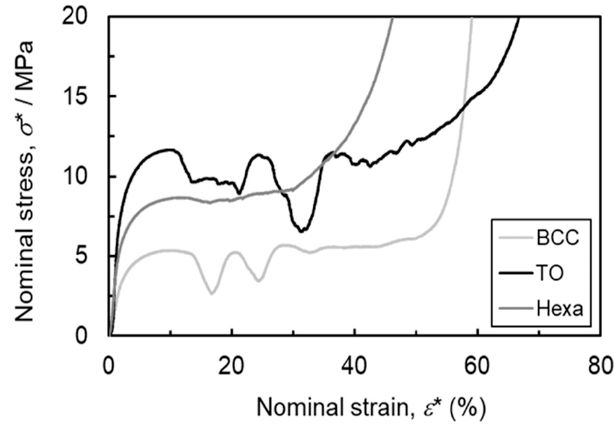
Figure 5. Nominal stress-strain curves of lattice structures consisting of the BCC ( ρ * / ρ s = 0.16), TO ( ρ * / ρ s = 0.17), and Hexa ( ρ * / ρ = 0.18) unit cells. s